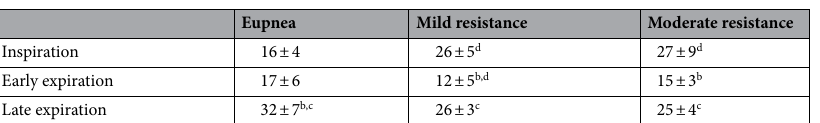
Table 2. Number of cardiac cycles in each respiratory phase across loading interventions. Data represent the number of cardiac cycles that occurred during each respiratory phase with eupneic breathing and mild and moderate resistance loads. Data are presented as mean ± SD. Two-way within-subjects ANOVA revealed a significant interaction with a main effect of respiratory phase. b Different from inspiration within a respiratory load. c Different from early expiration within a respiratory load. d Different from eupnea within a respiratory phase; p < 0.05 for all, n =